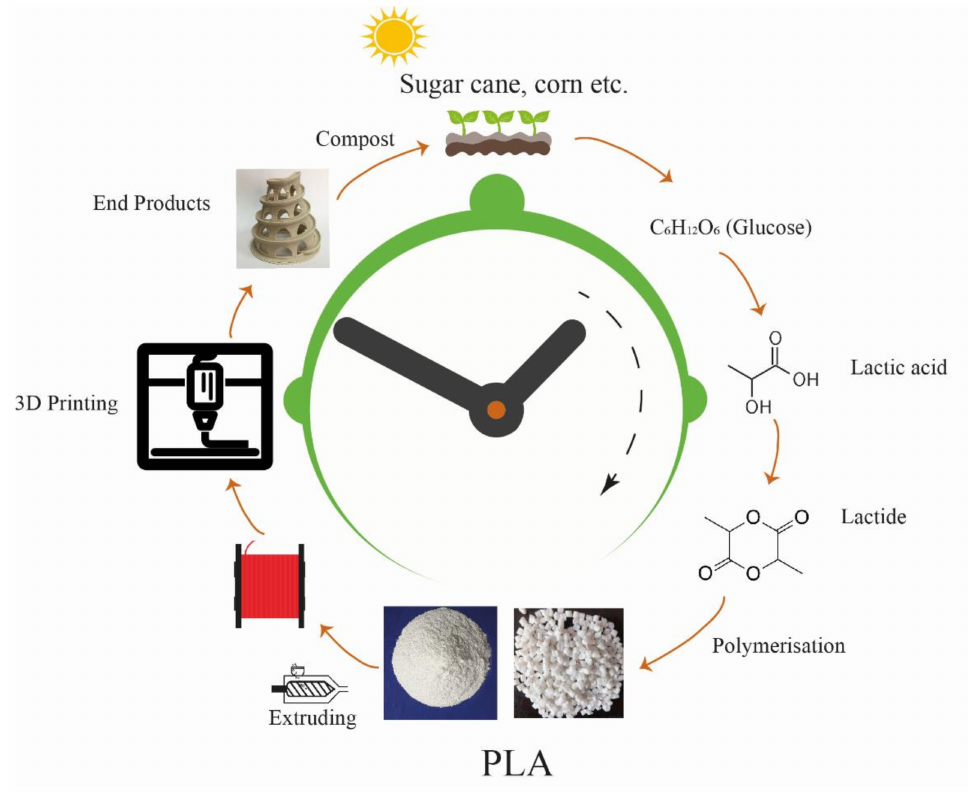
Figure 1. Environmentally friendly polylactic acid (PLA)